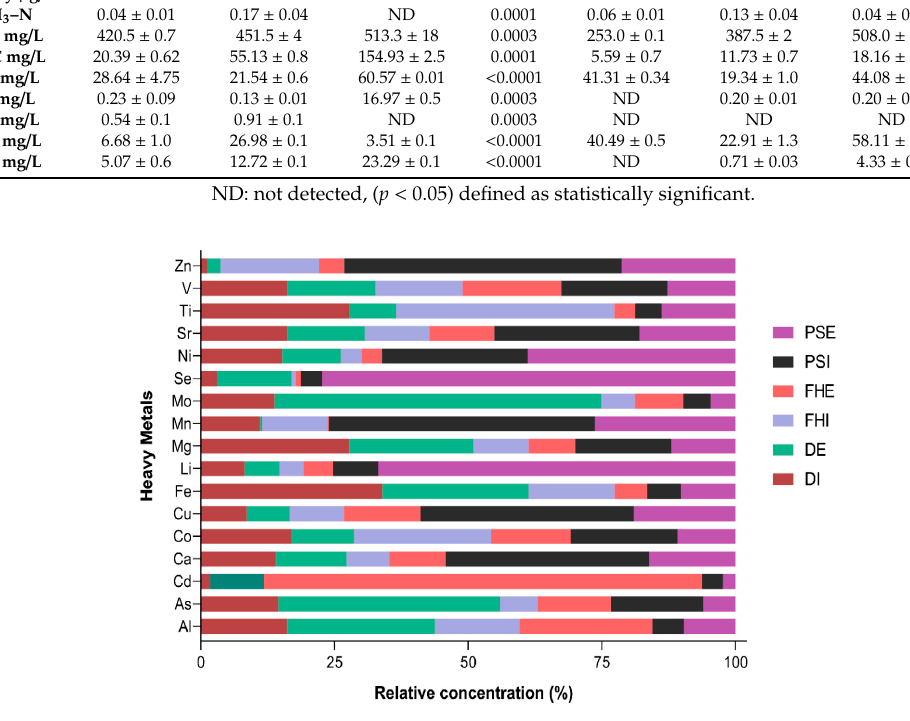
Table 1. Physicochemical properties of influent and e ffl uent water samples observed from three wastewater treatment plants (WWTPs). (Mean ± SD, n = 3).